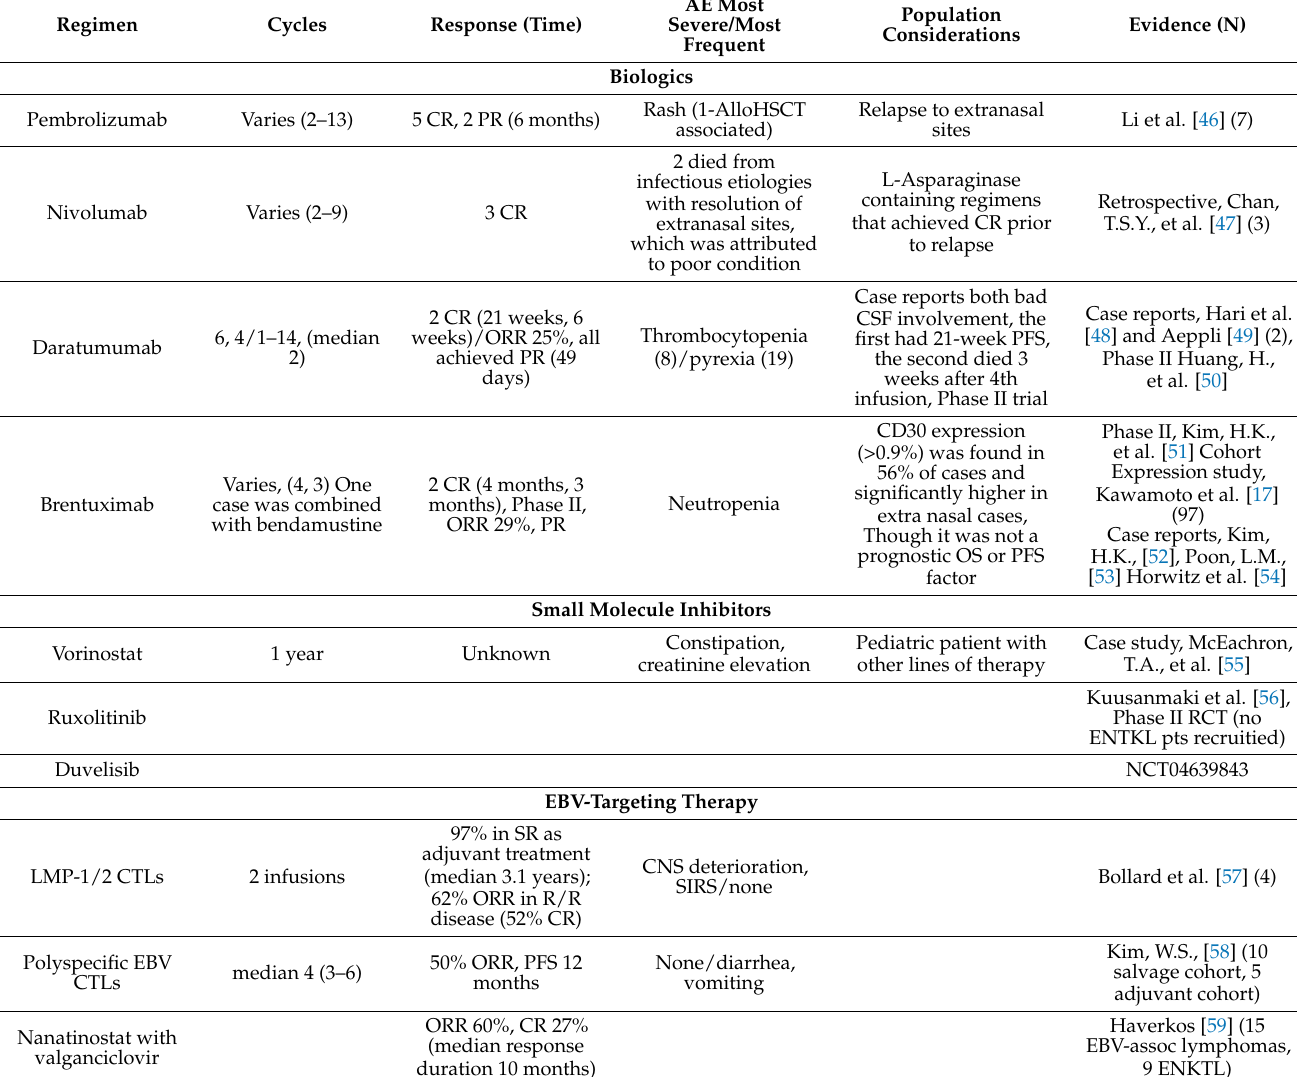
Table 2. Investigational therapies for